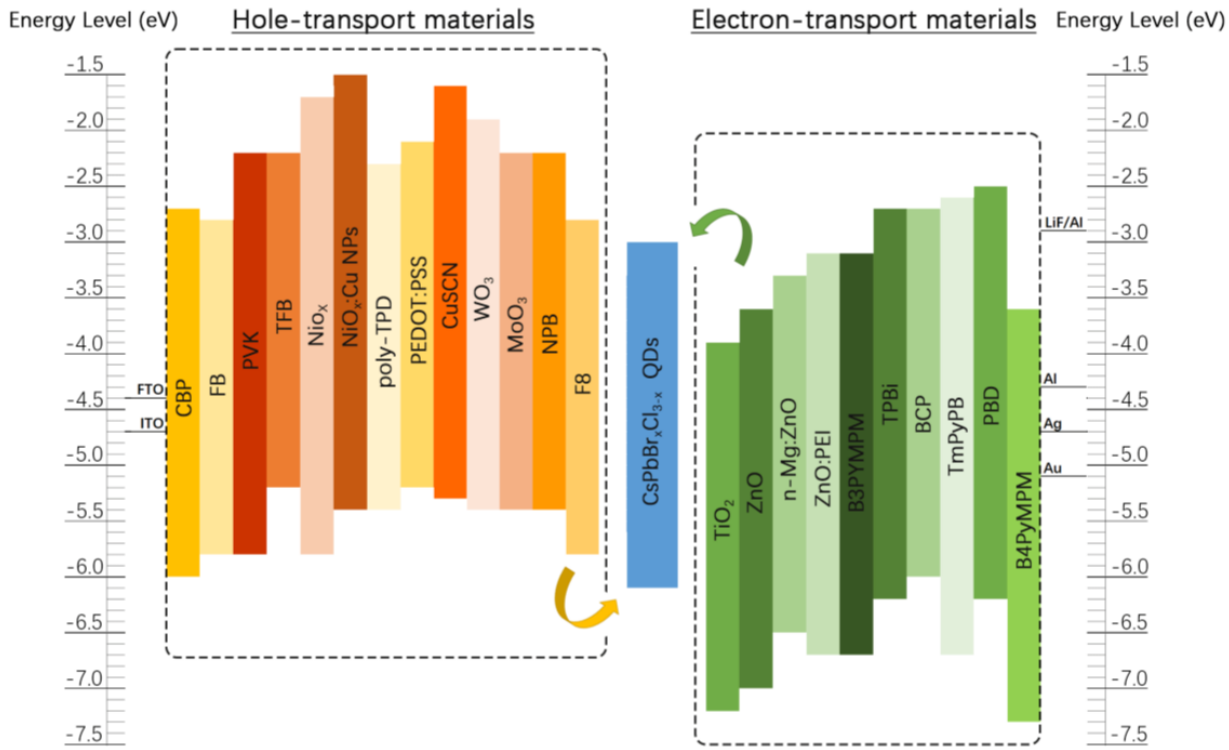
Figure 3. The energy diagram of the commonly used functional layers in PQD-LEDs.